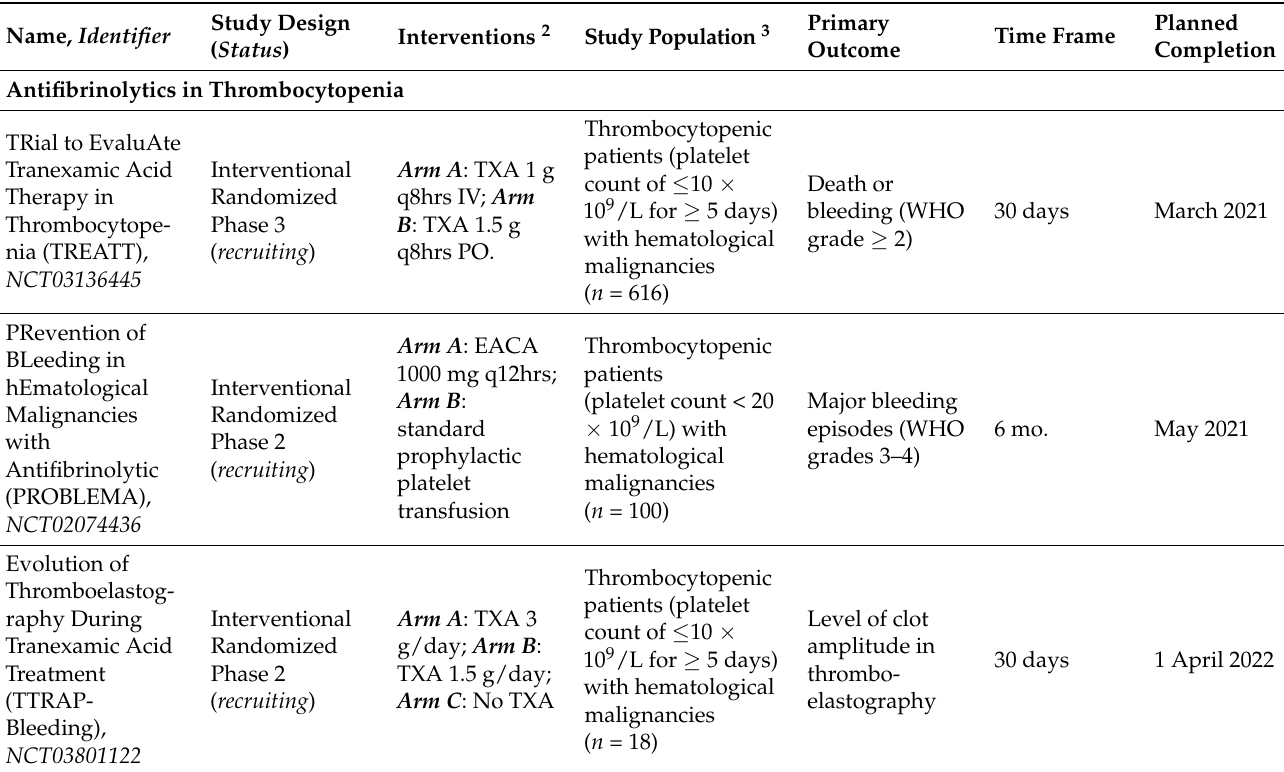
Table 1. Ongoing and planned clinical trials of antifibrinolytic agents in thrombocytopenic cancer patients 1.